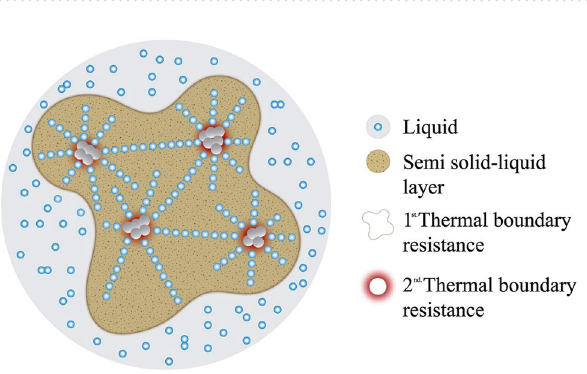
Figure 3. FT-IR spectra of the foamy semisolid top layer (M1, M2 and M3) along with the bulk melted NF with a 1 wt% concentration in NPs. M1 to M3 corresponds to the evolution of the top layer with temperature, from 300 to 450 °C. M4 corresponds to the spectrum of the entire NF once melted. The analyzed bands are identified by a number from 1 to 11. The 100% of transmittance for each spectrum is the base line at high wave numbers.